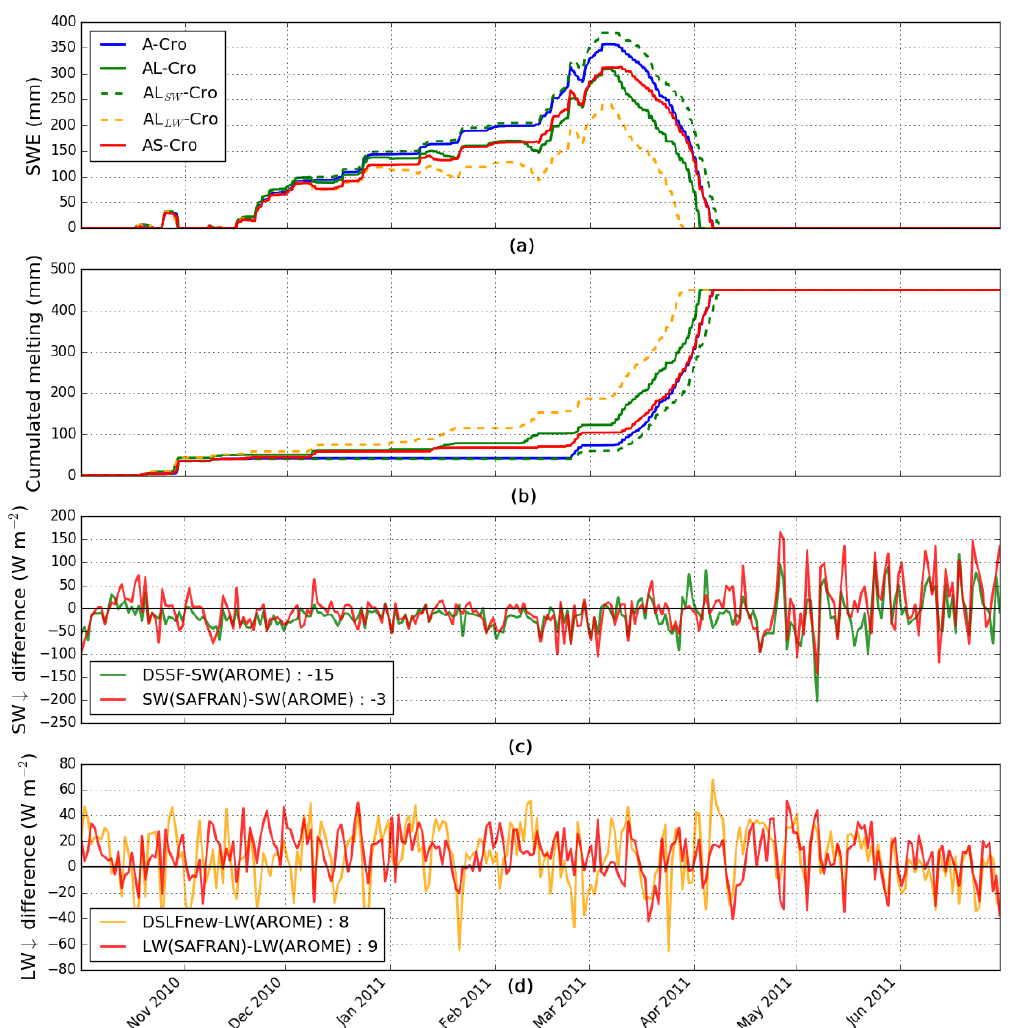
Figure 10. (a) Snow water equivalent simulated by A-Cro (blue), AL-Cro (green), AL SW (dashed green), AL LW (dashed orange) and AS- Cro (red) from 1 October 2010 to 30 June 2011 at point A in the Pyrenees (1359m, Fig. 9). (b) Cumulated melting represented with the same colours. (c, d) Mean daily irradiance differences with AROME for DSSF (green), DSLFnew (orange) and SAFRAN irradiances